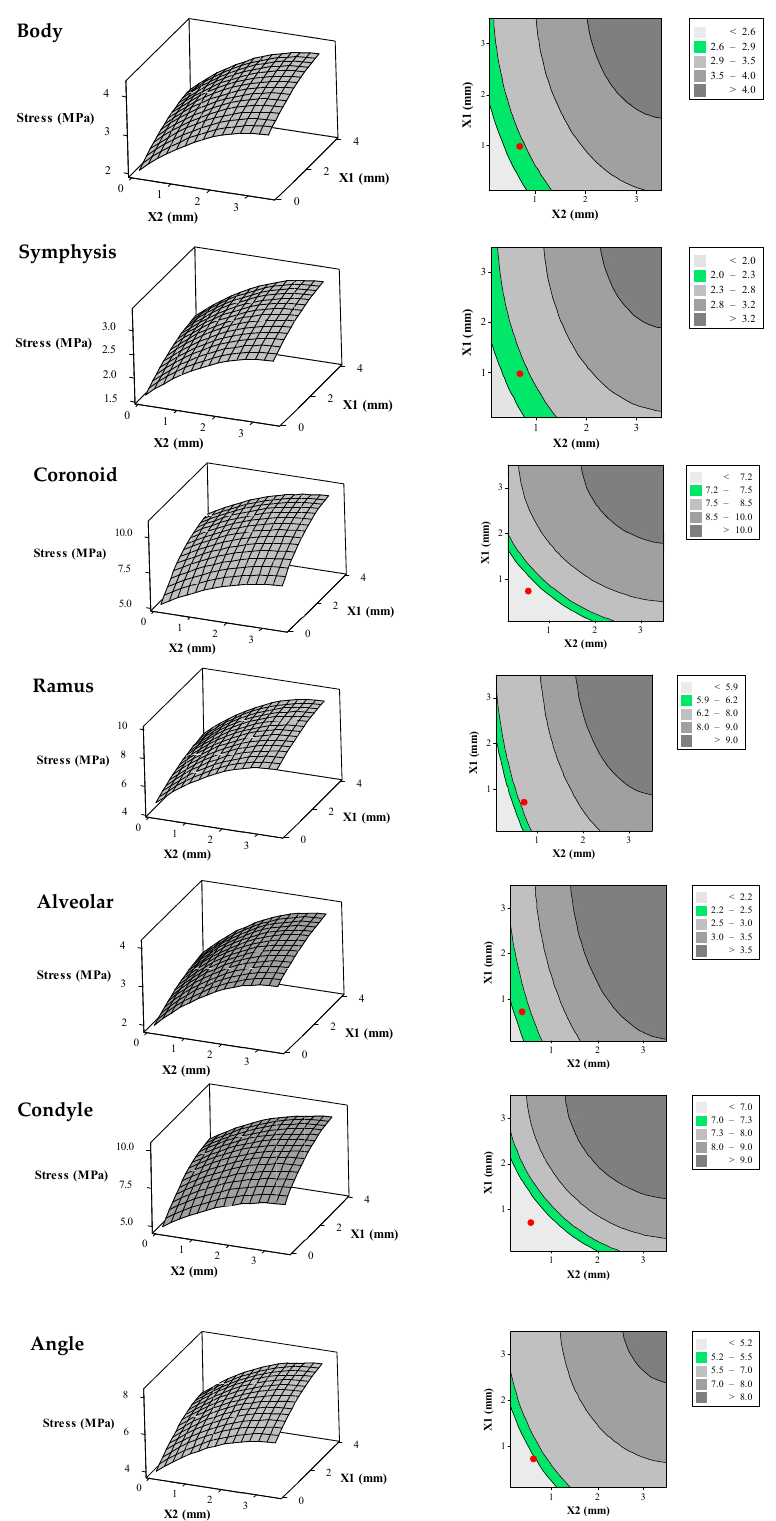
Figure 10. Surface plots ( left ) and their corresponding contour plots ( right ) representing average von Mises stress in the different zones of the reconstructed mandible (i.e., alveolar, symphysis, body, angle,